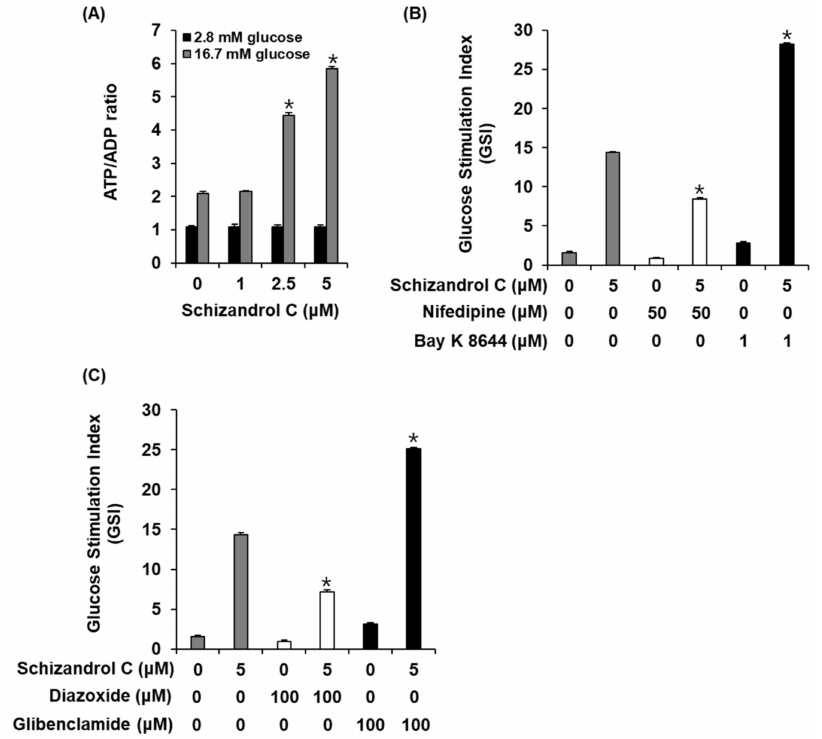
Figure 4. Effect of schisandrin C on ATP/ADP ratio and involvement of L-type Ca 2+ and K + channels in INS-1 cells. ( A ) ATP/ADP ratio in INS-1 cells after 1 h incubation with basal (2.8 mM) and stimulant (16.7 mM) concentrations of glucose in the presence or absence of schisandrin C assessed by ADP/ATP ratio assay. ( B ) Insulin secretion in INS-1 cells after 1 h incubation with basal (2.8 mM) and stimulant (16.7 mM) concentrations of glucose in the presence or absence of schisandrin C, nifedipine (L-type Ca 2+ channel blocker), and Bay K 8644 (L-type Ca 2+ channel activator) assessed by insulin secretion assay. ( C ) Insulin secretion in INS-1 cells after 1 h incubation with basal (2.8 mM) and stimulant (16.7 mM) concentrations of glucose in the presence or absence of schisandrin C, diazoxide (K + channel activator), and glibenclamide (K + channel blocker) assessed by insulin secretion assay. The data represent the mean ± S.E.M., n = 3, * p < 0.05 compared with the